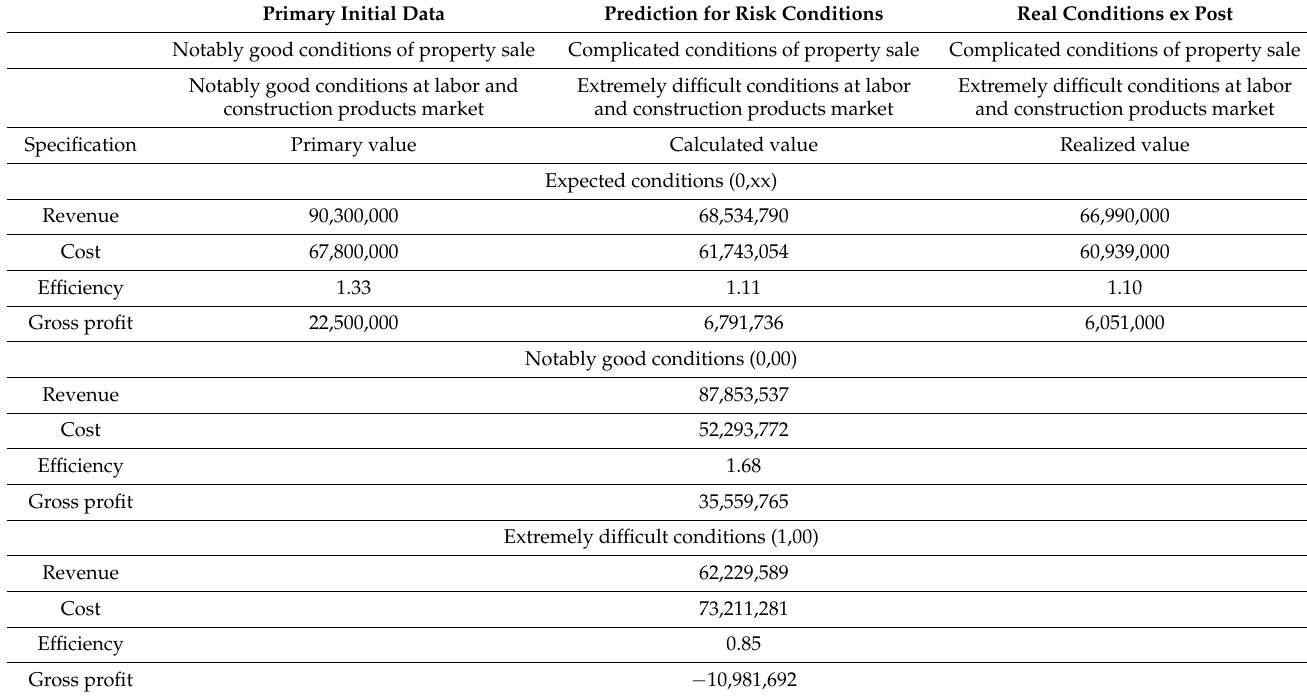
Table 5. Final results for conditions initially planned, actually expected, and really occurred for investment